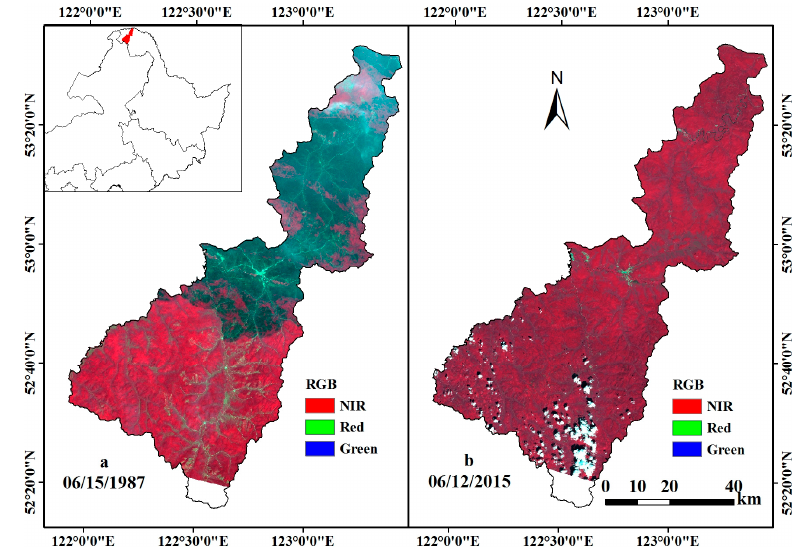
Figure 1. The study area and two example images in standard false color: Landsat 5 TM image in 1987 ( a ) and Landsat 8 OLI image in 2015 ( b ).